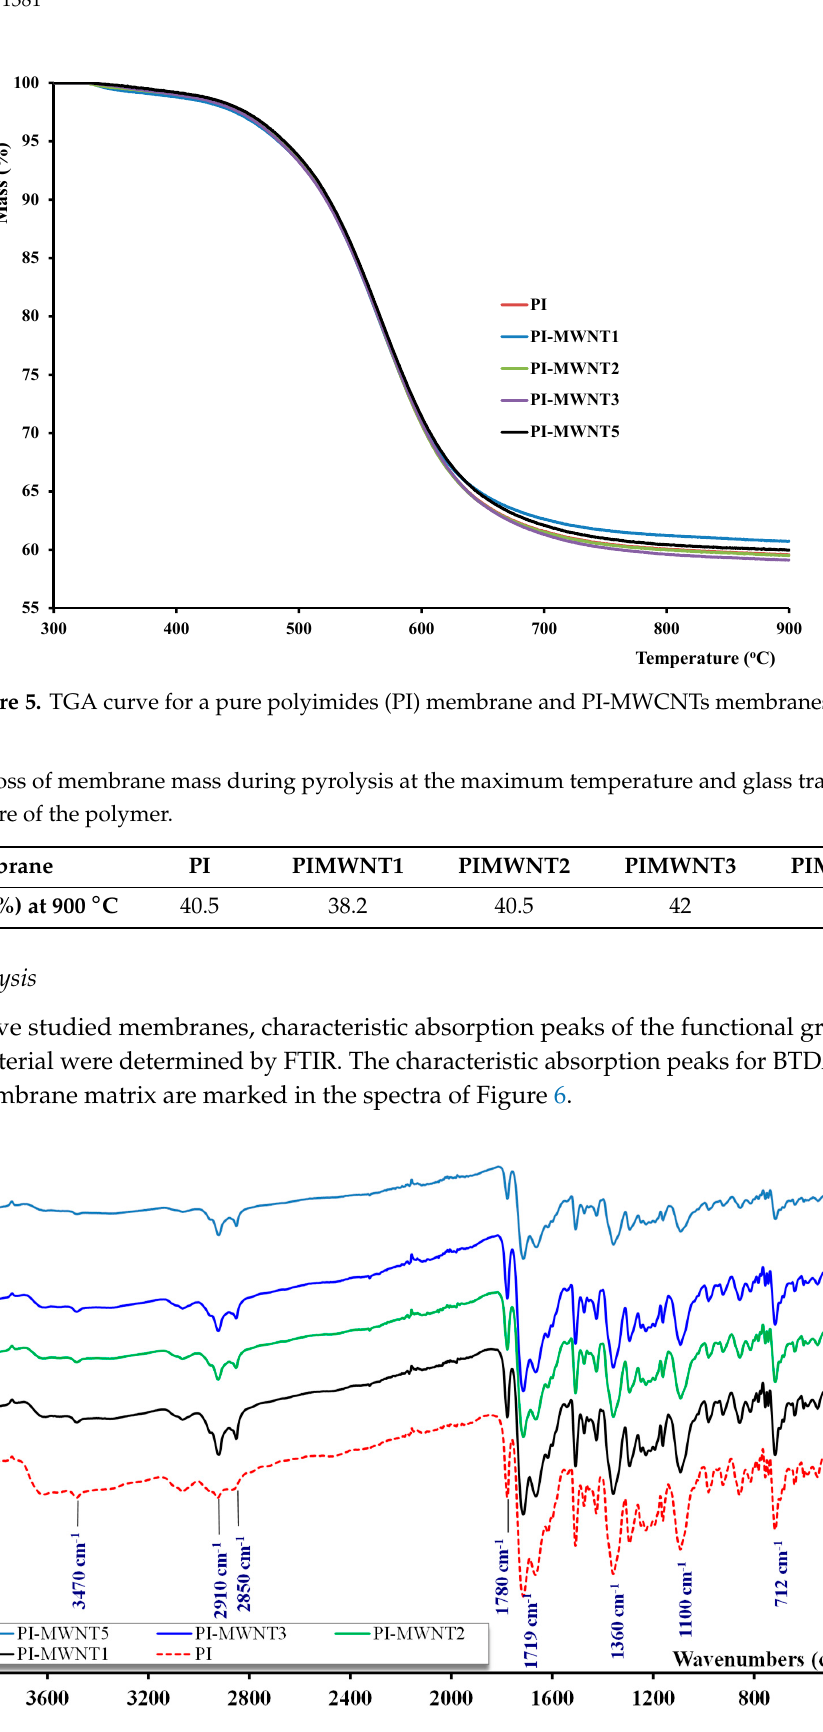
Figure 6. Absorption spectrum of samples PI, PI-MWNT1, PI-MWNT2, PI-MWNT3, and PI- MWNT5.